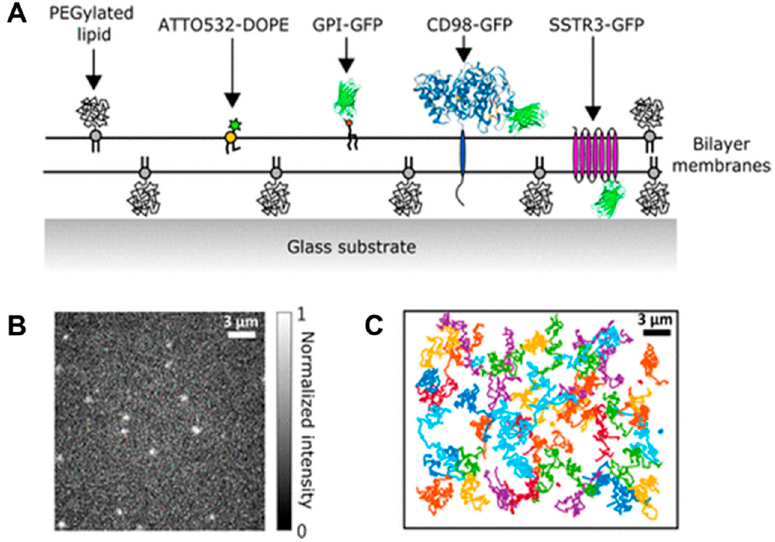
Figure 12. Single-molecule fluorescence imaging and tracking in polymer-cushioned plasma membrane bilayers. ( A ) Schematic of the membrane molecules studied in this work. ATTO532-DOPE is a dye-labeled phospholipid. GPI-GFP is a glycolipid, glycophosphatidylinositol (GPI), with a GFP attached to the headgroup. CD98-GFP heavy chain is a single-pass transmembrane protein, and it is fused with GFP at its C-terminus in the extracellular domain. SSTR3-GFP is a seven-pass transmembrane protein, and it is fused with GFP at its C-terminus in the cytoplasmic domain. ( B ) Snapshot of the fluorescence imaging of single GPI-GFPs. ( C ) Representative trajectories of GPI-GFPs in polymer-cushioned plasma membrane bilayers [332]. Reproduced from Wong et al. (2019) with permission (Copyright © American Chemical Society 2019).